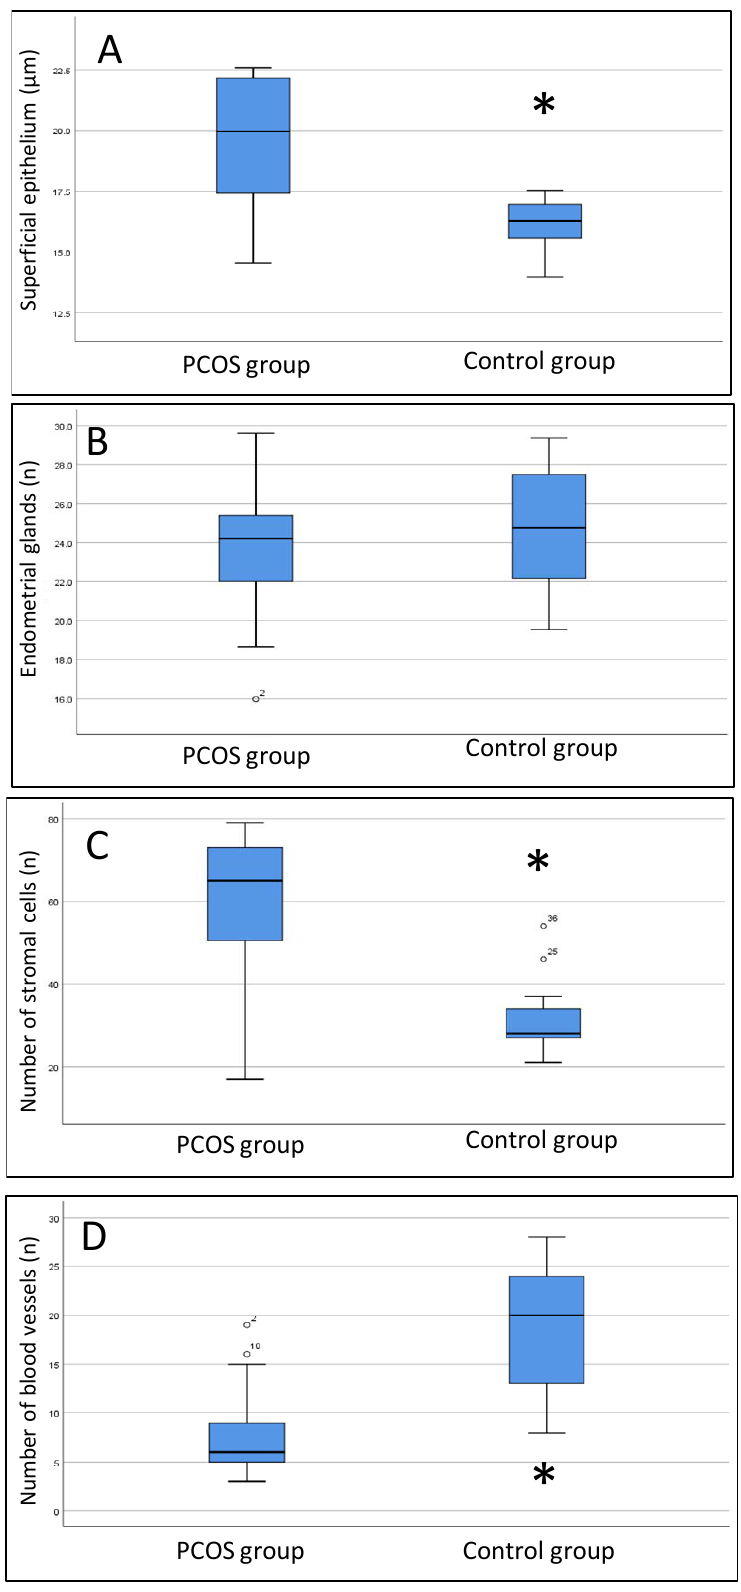
Figure 5. Box plot results of histomorphometric data. ( A ) thickness of the superficial epithelium; ( B ) number of endometrial glands; ( C ) number of stromal cells; ( D ) number of blood vessels. The Mann–Whitney U test was used. * PCOS group compared to the control group, p < 0.01.